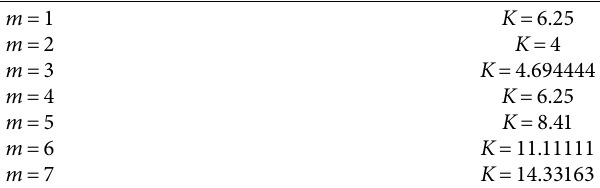
Figure 2: Tension coefficient figure ( k ) based on a / b ratio for different values of m (modes transformation) for the joint plate [22]. Table 3: Values of k based on tension modes.